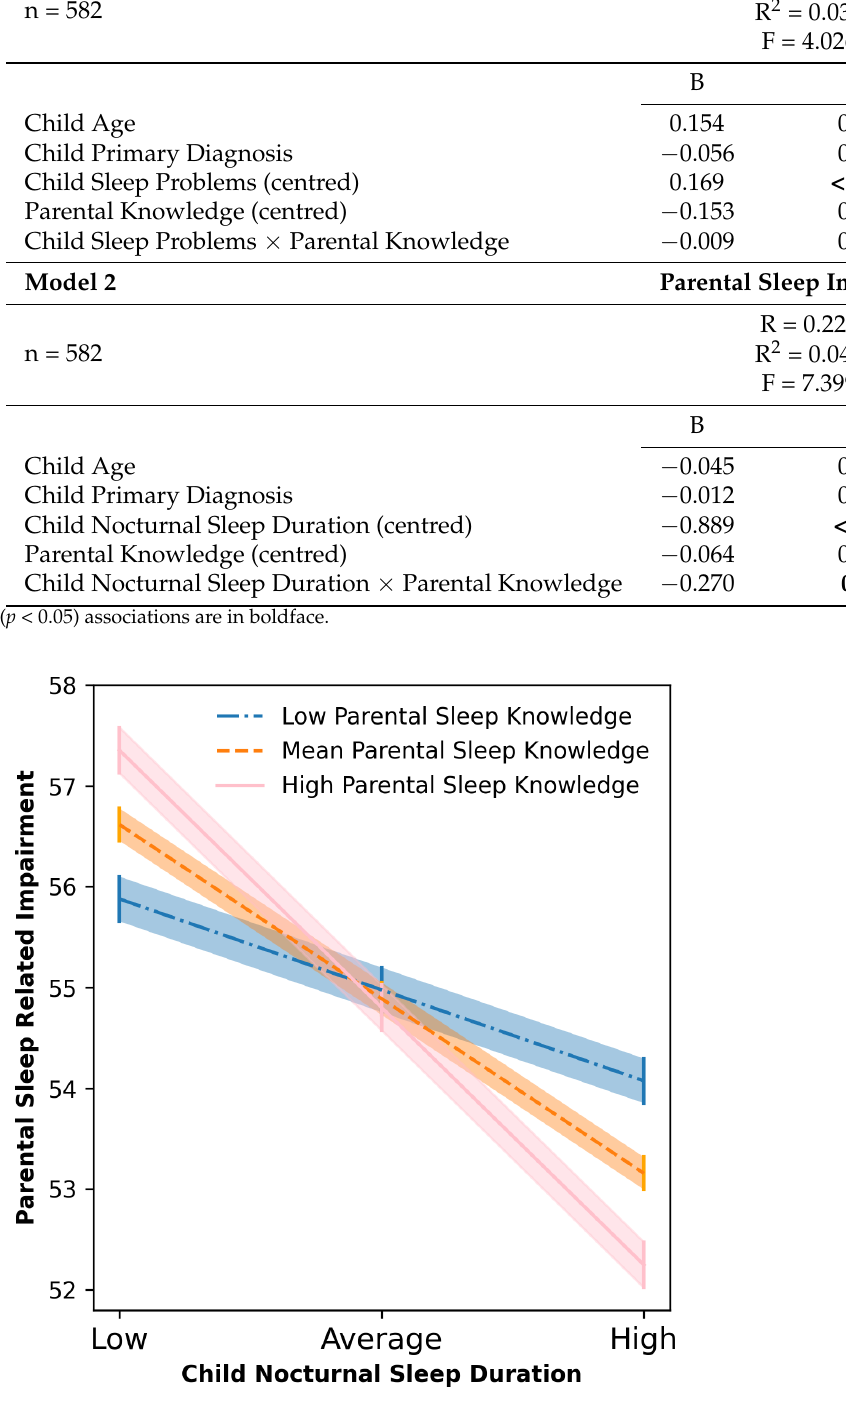
Figure 1. Moderation effect of parental knowledge on the relationship between total nocturnal sleep duration and parent sleep related impairment. Lines represent Means and bars and shades Standard Errors